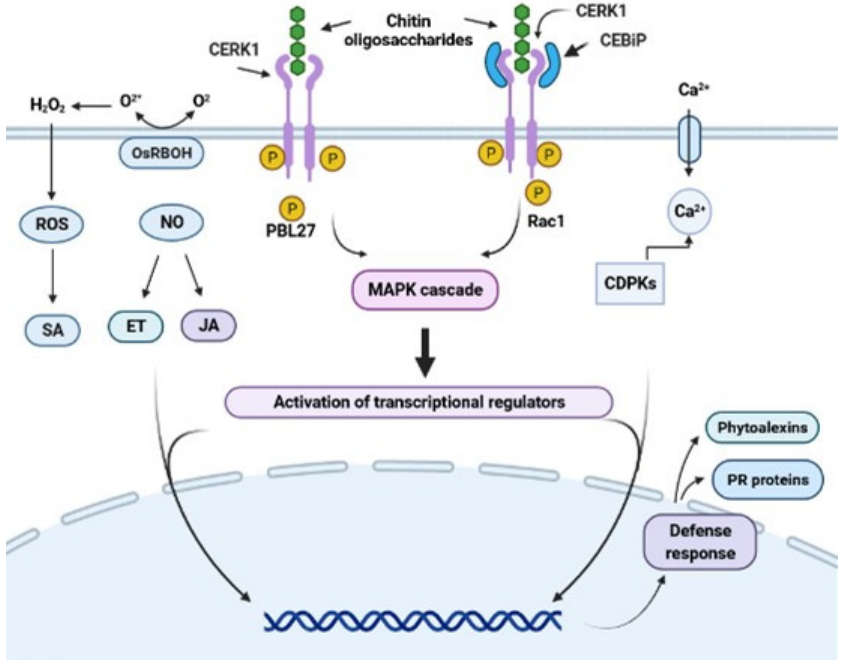
Figure 1. Representative scheme of chitin oligosaccharide perception by the chitin receptors RLK and RLP. Structural differences between the RLP (CEBiP) and RLK (CERK1) receptors are shown. Chitin oligosaccharides bind to CERK1 in Arabidopsis . This complex sends the signal to the intermediate protein, which will begin to phosphorylate and trigger the MAP kinase pathway, inducing the accumulation of SA, JA, ET, NO, and ROS and activating the defense responses. The CEBiP receptor in rice binds to CERK1, forming a heterodimer complex that will allow it to recognize chitin oligosaccharides and activate its defense mechanism in the same way. Figure created using BioRender (https://biorender.com/ accessed on 22 July 2021).